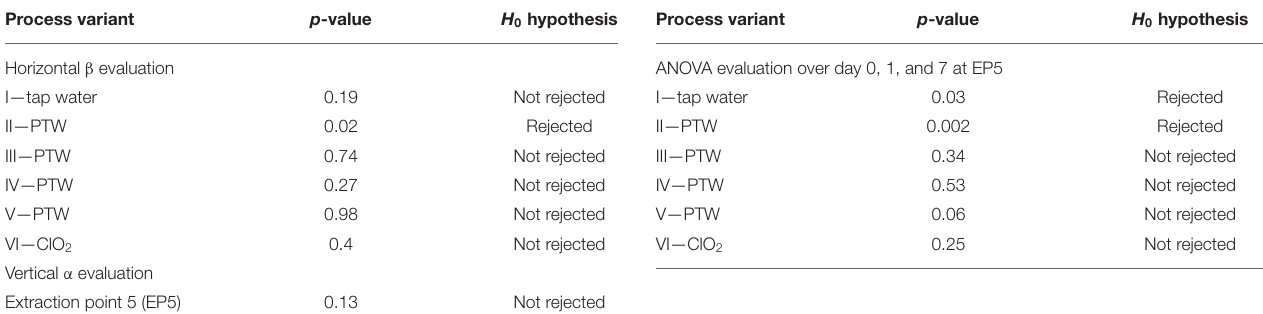
TABLE 9 | Statistical evaluation over all storage days (day 0, 1, and 7) at